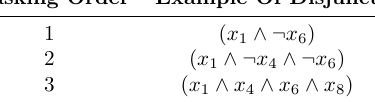
Figure 5: Example of disjuncts of TTSCA small necessary for key recovery and a visual- ization of a simulated trace.